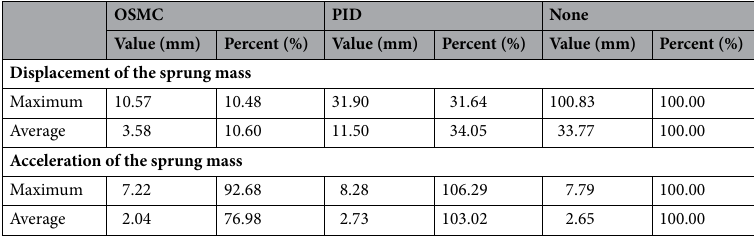
Table 4. Results of the case 3.